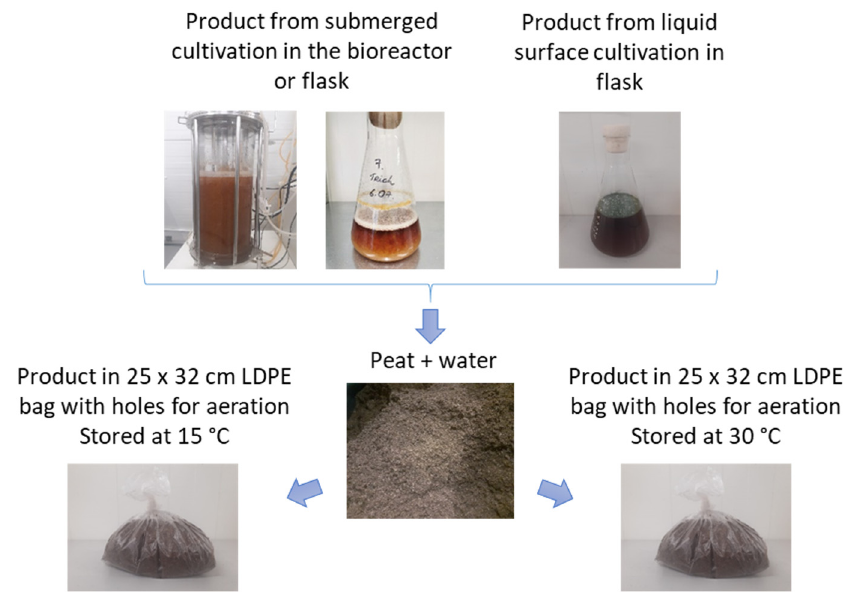
Figure 1. A schematic illustration of the storage